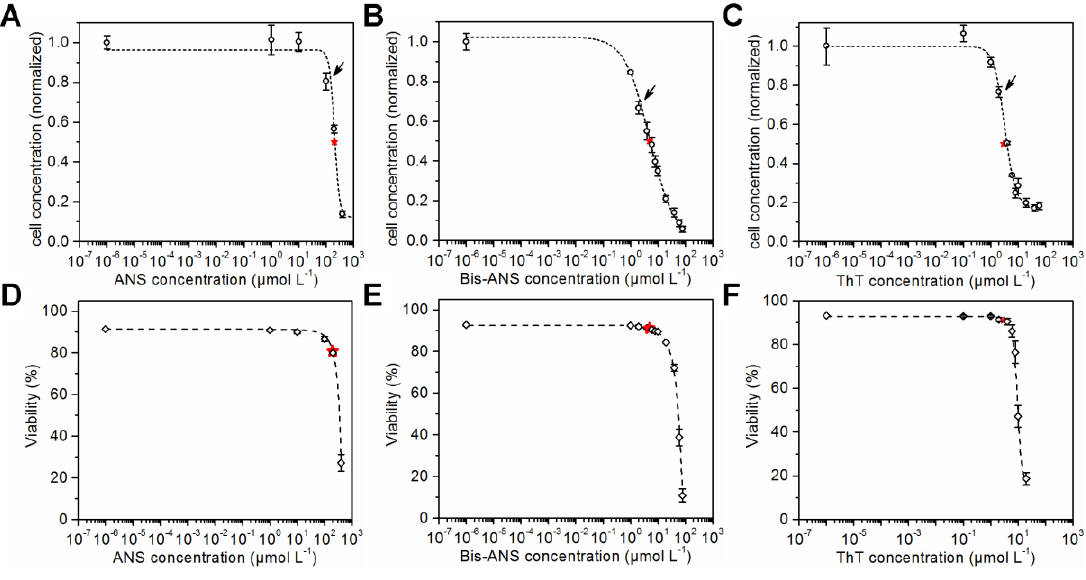
Figure 1. Cell concentration after 72 h cultivation in the presence of ANS (IC50 of 203 ± 11 µmol·L −1 ), Bis-ANS (IC50 of 5 ± 0.5 µmol·L −1 ) and ThT (IC50 of 3 ± 0.2 µmol·L −1 ) ( A – C ) and the corresponding viabilities ( D – F ) are shown. A sigmoid curve fit was performed in order to determine the corresponding IC50s (indicated by red stars). Arrows indicate the dye concentrations that were used later in the corresponding fed-batch processes.